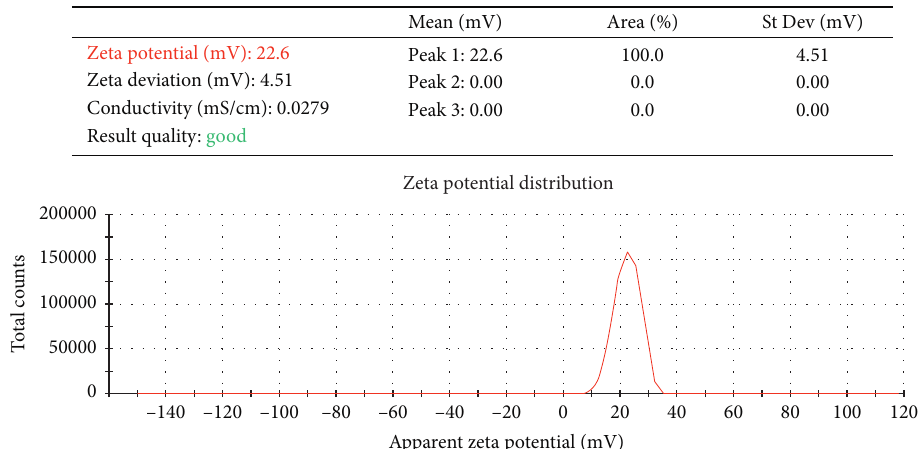
Figure 2: Particle size distribution of starch particles.